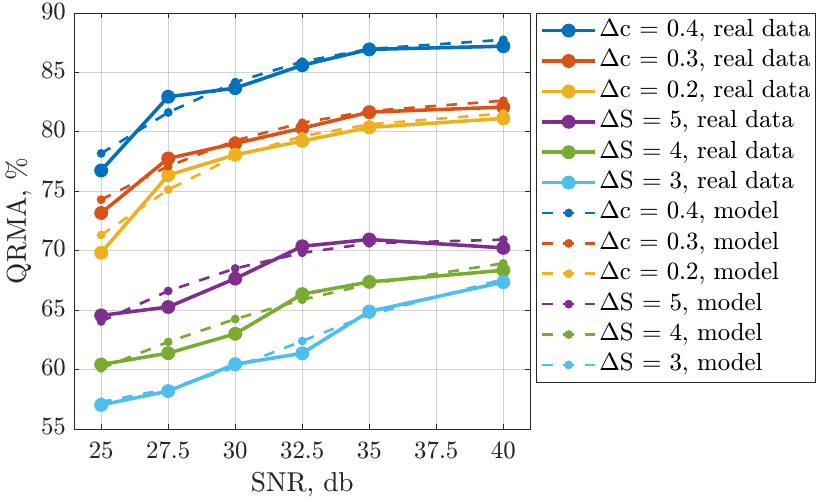
Figure 10. QRMA vs. SNR